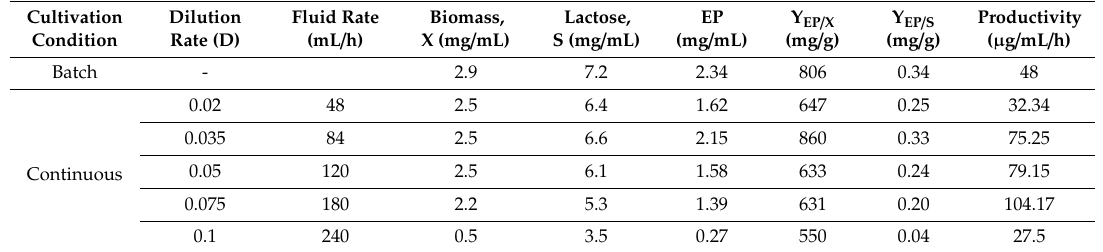
Table 1. Process parameters in batch and continuous cultures for exopolymer (EP) production by C. canadensis 28.